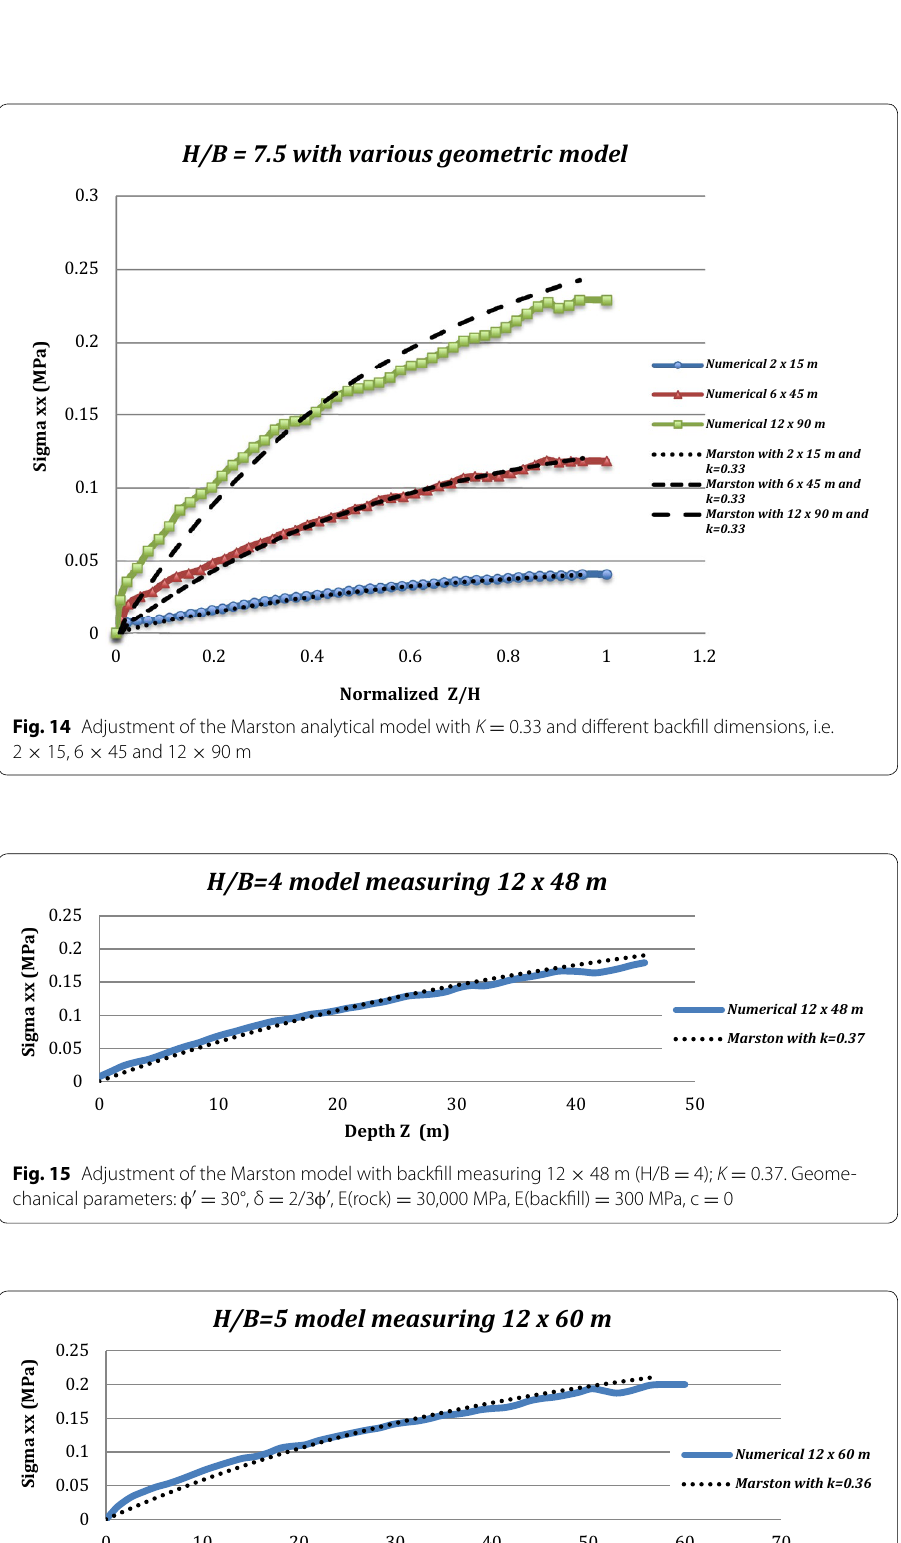
Fig. 16 Adjustment of the Marston model with backfill measuring 12 chanical parameters: φ ′